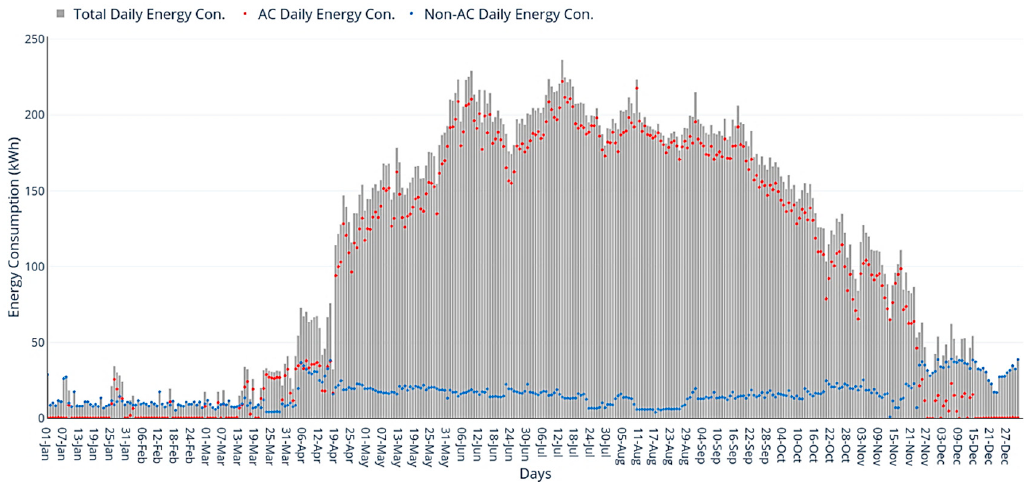
Figure 6. Daily air conditioning (AC) versus non-AC load energy consumption (April 2018 to April 2019).